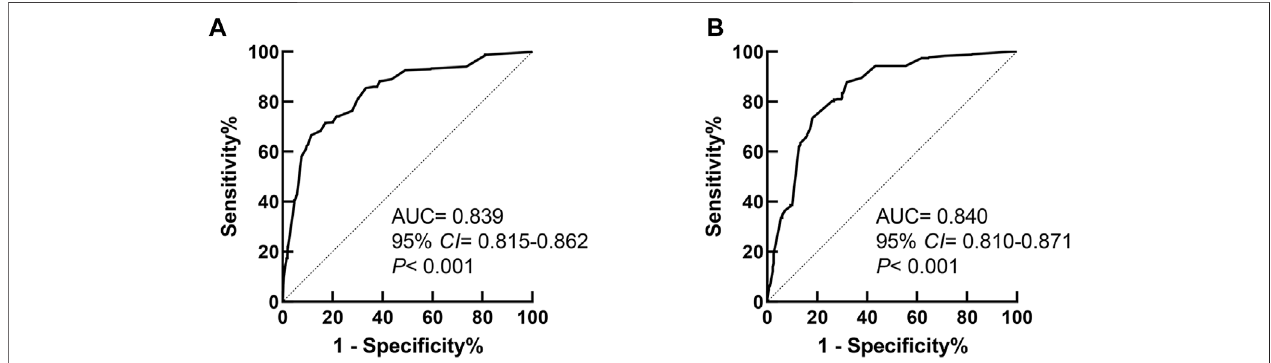
FIGURE3| ReceiveroperatorcharacteristiccurveofthepredictionmodelforPMIinCohort1andCohort2. (A) TheROCcurveofthepredictionmodelinCohort1. (B) The ROC curve of the prediction model in Cohort 2.